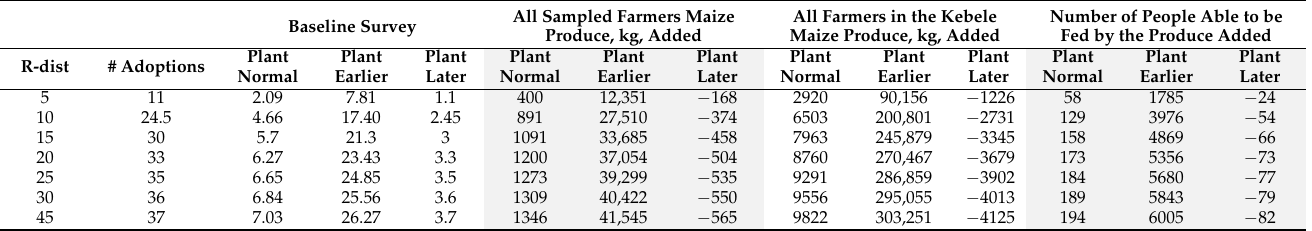
Table A2. Adoption rate of farmers’ interactions with neighbor farmers (Musayev et al., 2021), crop productivities of adopted numbers, and number of people able to be fed under more rain conditions.